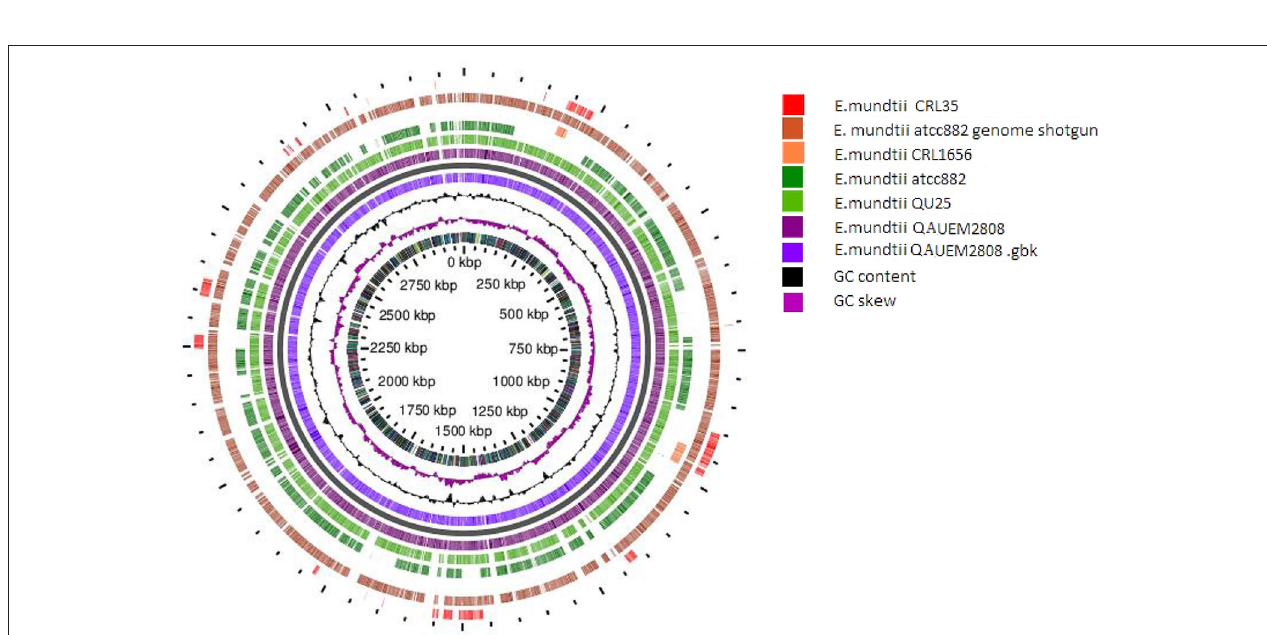
FIGURE 9 | Circular map of E. mundtti QAUEM2808 genome and Comparative genomics. comparison with other E. mundtii genomes available at the time of analysis result,